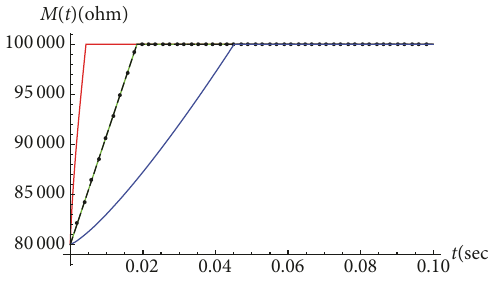
Figure 2: 𝑀(𝑡) of the fractional order memristor excited by a -110 𝜇 A DC waveform: 𝛼 = 0.75 (red), 𝛼 = 1 (green), 𝛼 = 1.25 (blue), and HP memristor (black